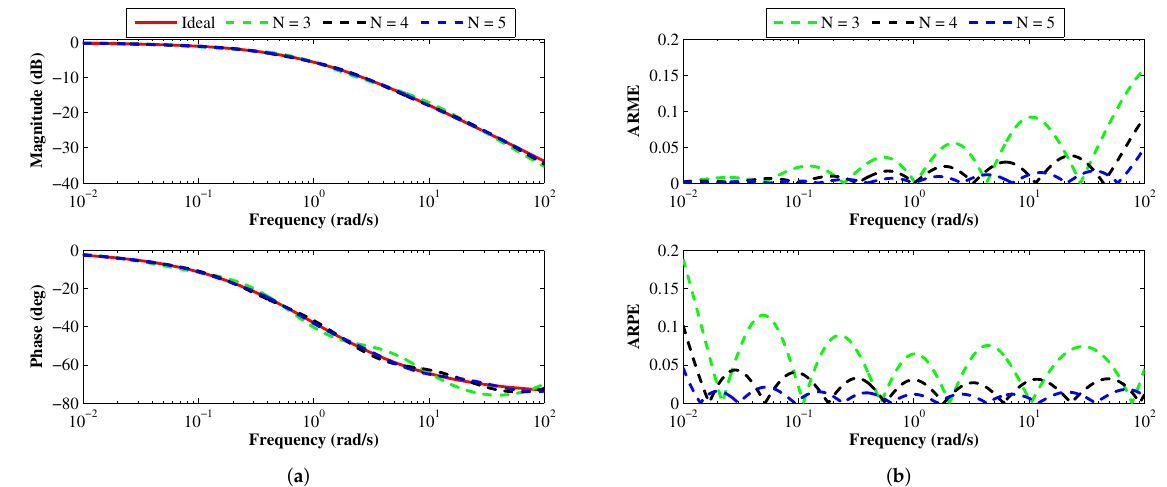
Figure 4. ( a ) Magnitude, phase and ( b ) ARME, ARPE responses of the proposed FLPF ( α = 0.7, β = 0.6) for different values of N .